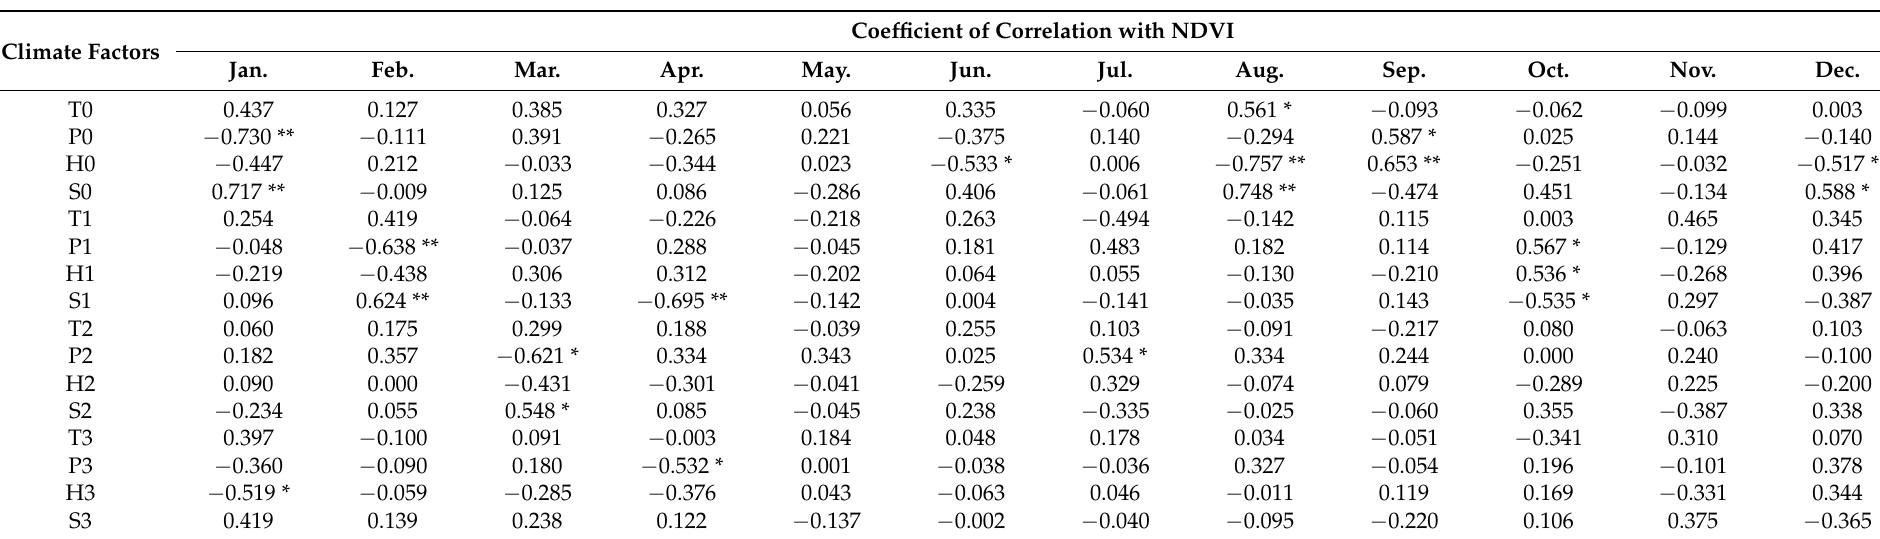
Table 5. Pearson correlation coefficients between NDVI in each month and climatic factors in the current and previous one, two, and three